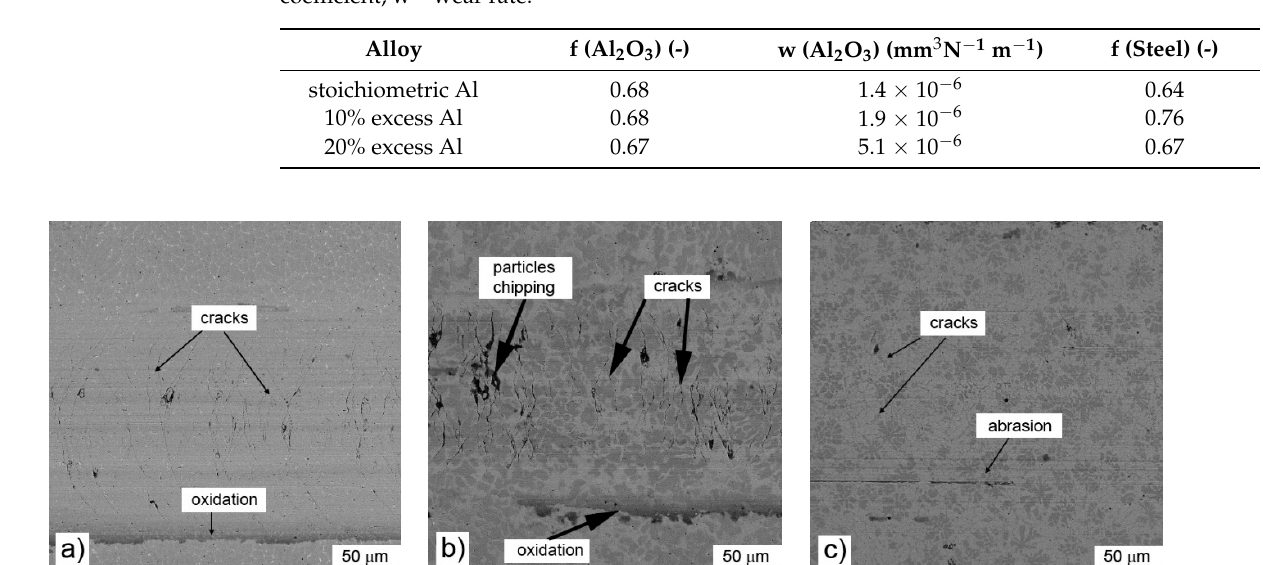
Table 6. Tribological properties of tested alloys against Al 2 O 3 and steel (100Cr6) balls: f—friction coefficient, w—wear rate.